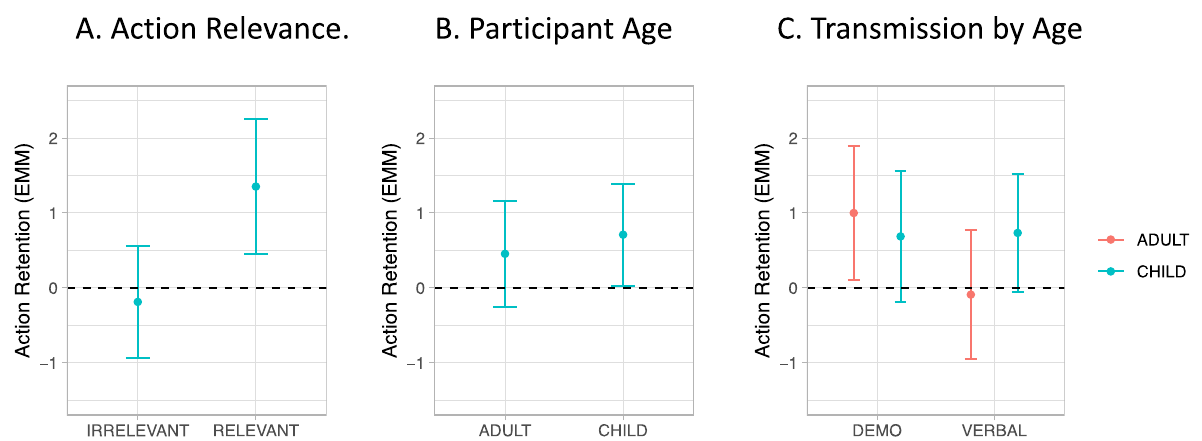
Fig. 3 Estimated marginal means of action Retention (Log odds) with 95% CIs. Panel A compares conditions of action Relevance and panel B , conditions of participant Age. Panel C illustrates the interaction between participant Age and Transmission.